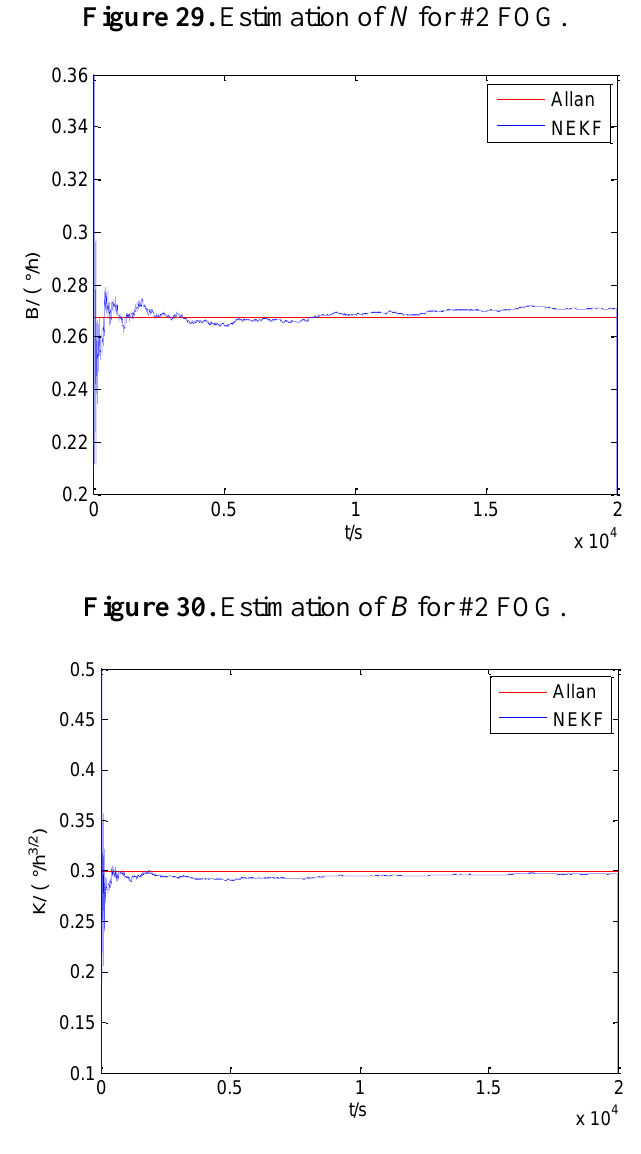
Figure 31. Estimation of K for #2